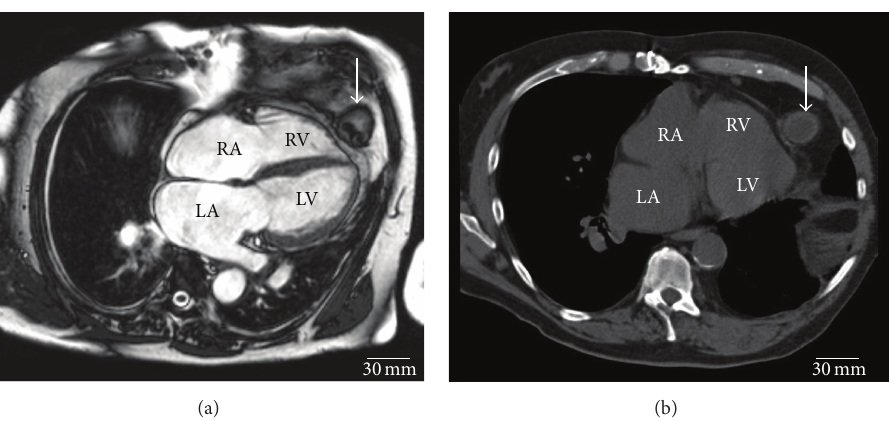
Figure 1: Epicardial foreign body (arrow) with a diameter of 30mm in (a) cardiac magnetic resonance imaging (MRI) and (b) thoracic computed tomography (CT): diffuse thickening of the pericardium surrounding the foreign body with pericardial effusion is shown. RA denotes right atrium, LA left atrium, RV right ventricle, and LV left